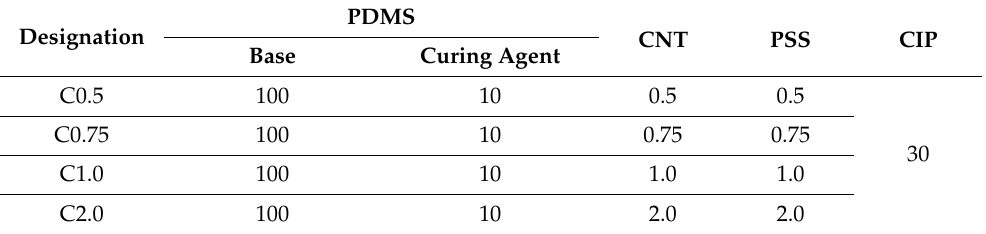
Table 1. Mix proportions of the specimens fabricated in the present study (wt.%).